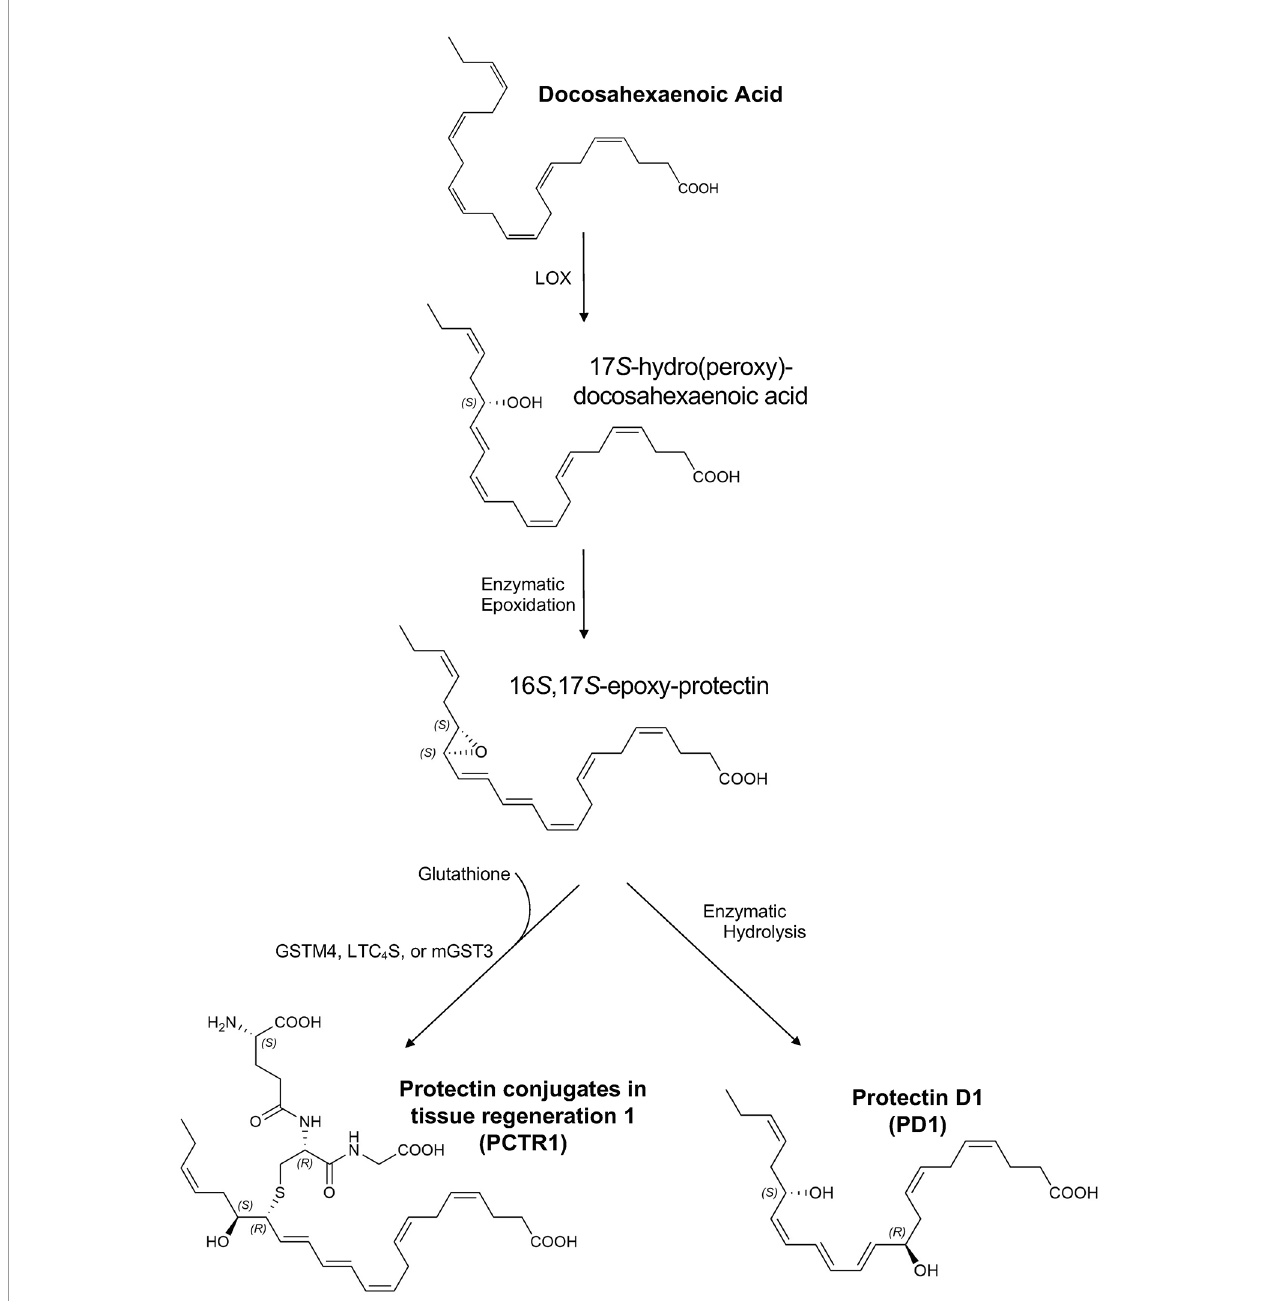
FIGURE 1 | Proposed biosynthesis of protectin conjugates in tissue regeneration 1 (PCTR1) and protectin D1 (PD1). Docosahexaenoic acid (DHA) is converted to 17 S -hydro(peroxy)-docosahexaenoic acid (17 S -H(p)DHA) via 15-lipoxygenase (LOX) in human cells and 12/15-LOX in mice (5, 6). Enzymatic epoxidation of 17 S -H(p) DHA produces the 16 S ,17 S -epoxy-protectin intermediate (5, 6). Enzymatic hydrolysis of the 16 S ,17 S -epoxy-protectin intermediate generates protectin D1 (PD1) (5, 6) and glutathione S-transferase-mediated (LTC 4 S, leukotriene C 4 synthase; GSTM4, glutathione S-transferase Mu 4; mGST3, microsomal glutathione S-transferase 3) S N 2 reaction with glutathione produces protectin conjugates in tissue regeneration 1 (PCTR1) (4, 7, 8). The products and intermediates are depicted in their assigned complete stereochemical con fi gurations (4 –